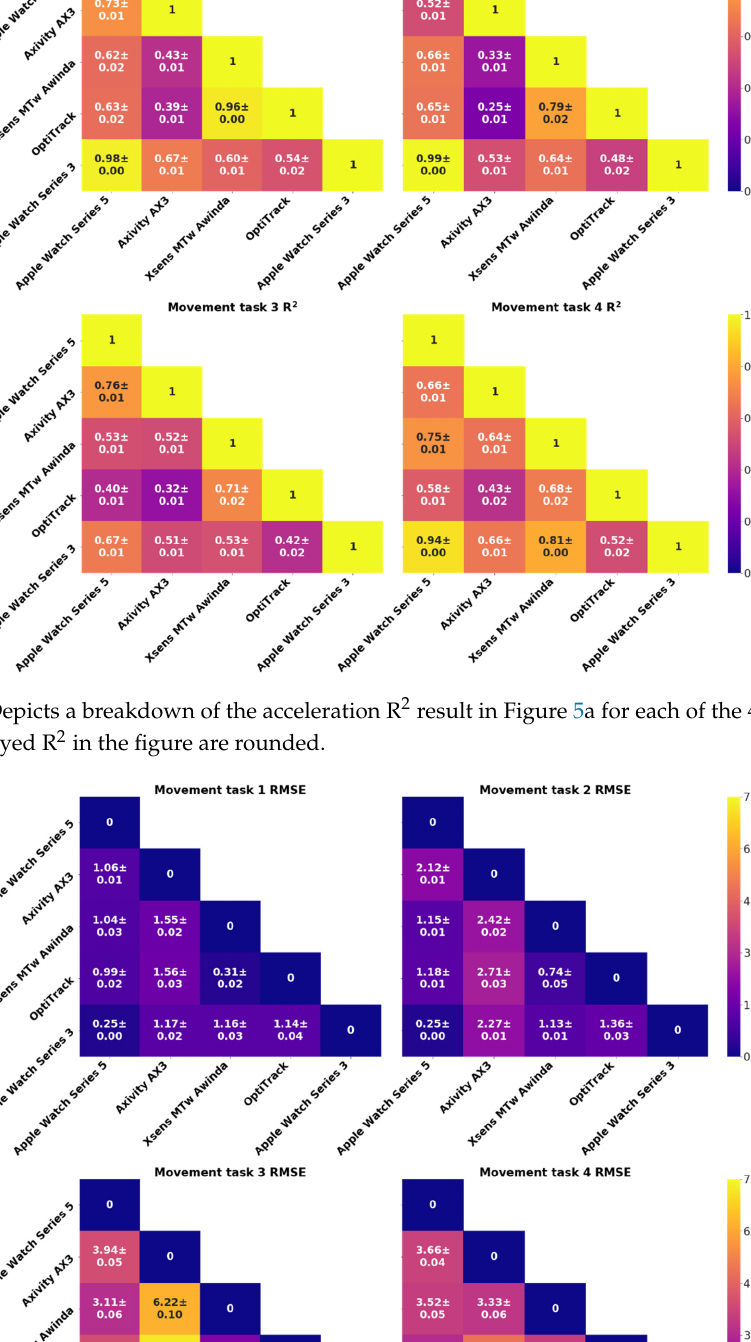
Figure A1. Depicts recorded IMU signal from Apple Watch Series 5 (top of stack) and Apple Watch Series 3 (bottom of the stack) where ( a ) are accelerations and their differences and ( b ) are angular velocities and their differences. The coloured area indicates different behavioural execution as depicted in Figure 3, i.e., is